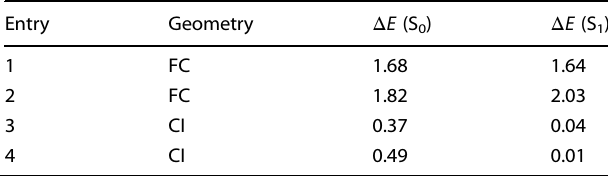
Fig. 7 Comparison of VQD with different parameter β and VQE/AC for phenol blue. Energy deviations Δ E (in kcal mol − 1 ) from the exact values for S 0 at the FC ( a ), S 1 at the FC ( b ), S 0 at the CI ( c ), and S 1 at the CI ( d ) were calculated using the SA-CASSCF method. The errors in energy obtained by the statevector and noisy-QASM simulators are shown in red and blue, respectively. Detailed values are shown in Supplementary Table 4. Table 2. Energy deviations Δ E (in kcal mol − 1 ) from the exact values of phenol blue for the S 0 and S 1 energies at the FC and CI geometries measured on the ibm_kawasaki